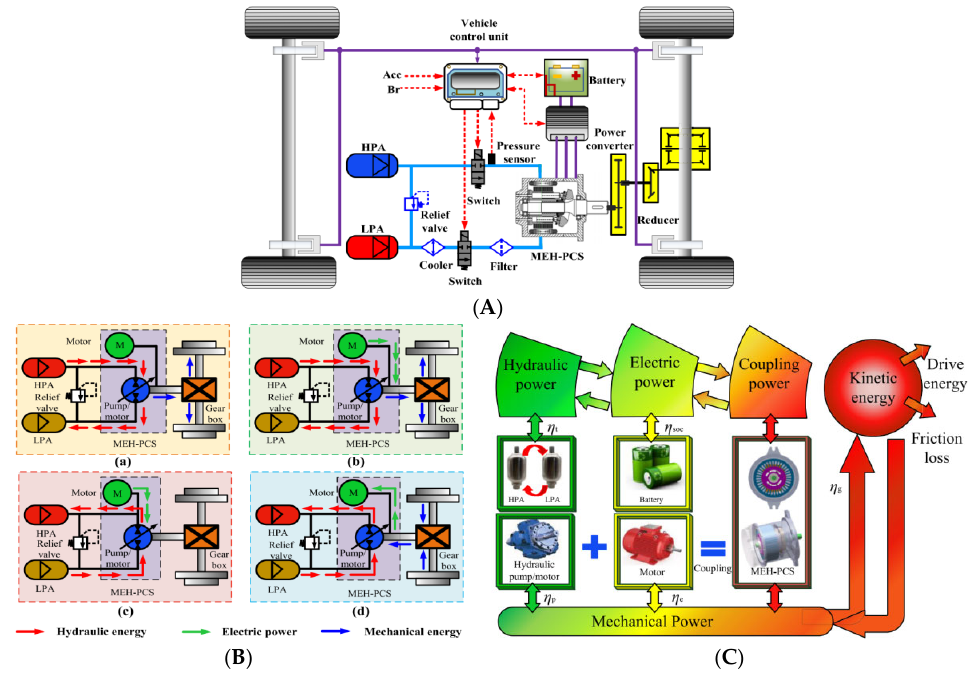
Figure 16. Mechanical–electric–hydraulic dynamic coupling drive system [98]: ( A ) diagram of the structure; ( B ) validation model for the MEH ‐ PCEV, ( a ) energy flow in HD mode, ( b ) energy flow in EHD mode, ( c ) energy flow in Idle mode, ( d ) energy flow in RB mode; ( C ) test rig diagram of MEH ‐ PCS.